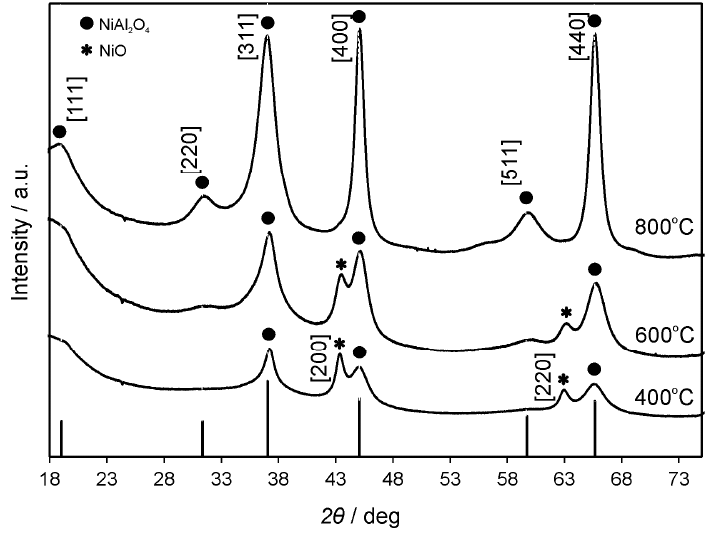
Figure 2. X-ray diffraction (XRD) patterns of NiAl 2 O 4 annealed at 400, 600 and 800 °C.